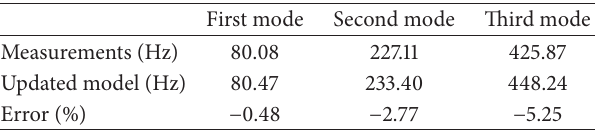
Table 4: Comparison of natural frequencies from measurements and updated model for single damage